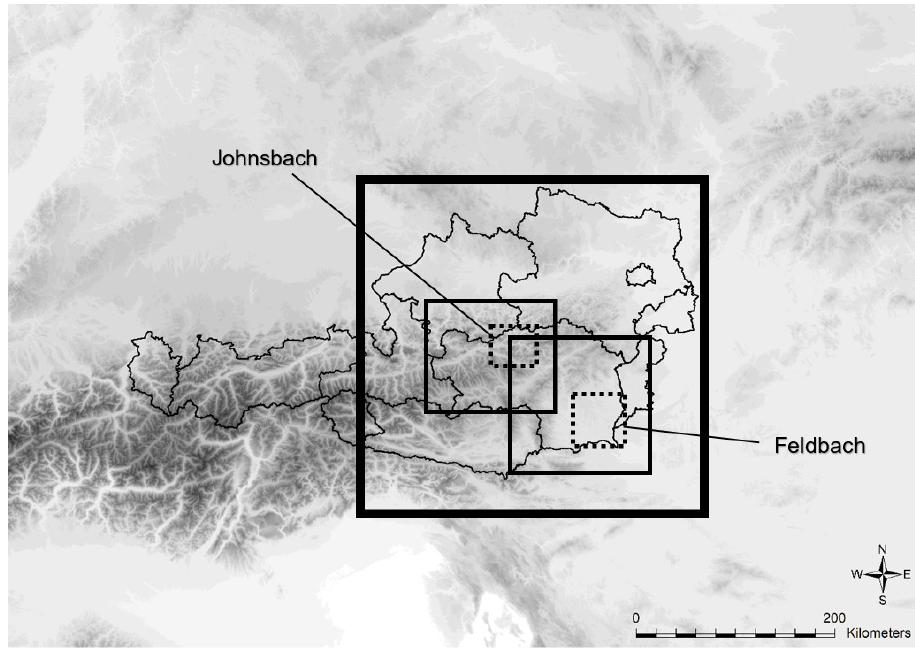
Figure 1. Locations of the modelling domains: domain 1 (5000 m horizontal resolution, thick black line), two nested domains (1000 m horizontal resolution, thin black lines), and two downscaling domains (200 m horizontal resolution, dotted lines).